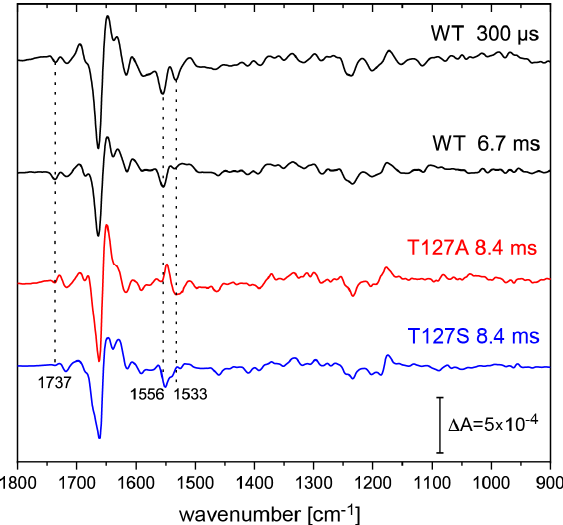
Figure 8. Time-resolved FTIR difference spectra of ChR2-WT (black spectra, taken from Reference [13]), T127A (red spectrum), and T127S variants (blue spectrum). The ChR2-WT spectrum at 300 µs and 6.7 ms was dominated by the P 2380 and P 3530 states, respectively. The spectra of the T127 variants were recorded at 8.4 ms, at which the P 2380 with smaller contributions of P 3530 was predominant.